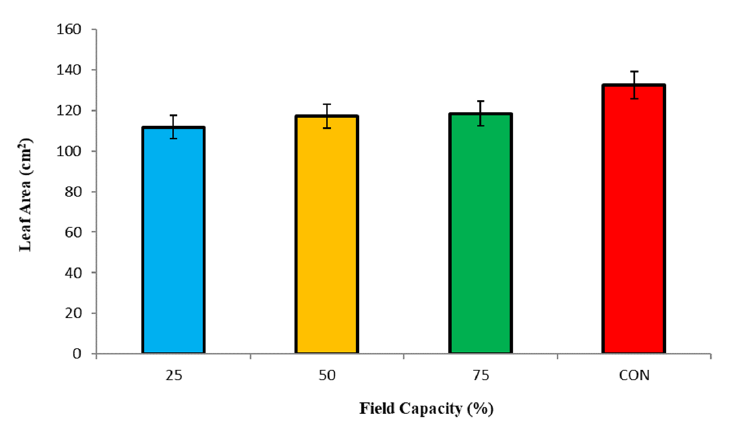
Figure 8. Effect of water deficit on cumulative mean leaf area of okra Data in the interaction analysed with Least Squares Means, and means separated with LSD